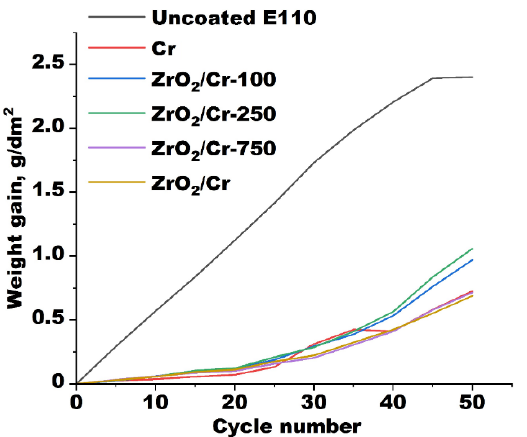
Figure 3. The dependence of the weight gain of the samples on a cycle number.